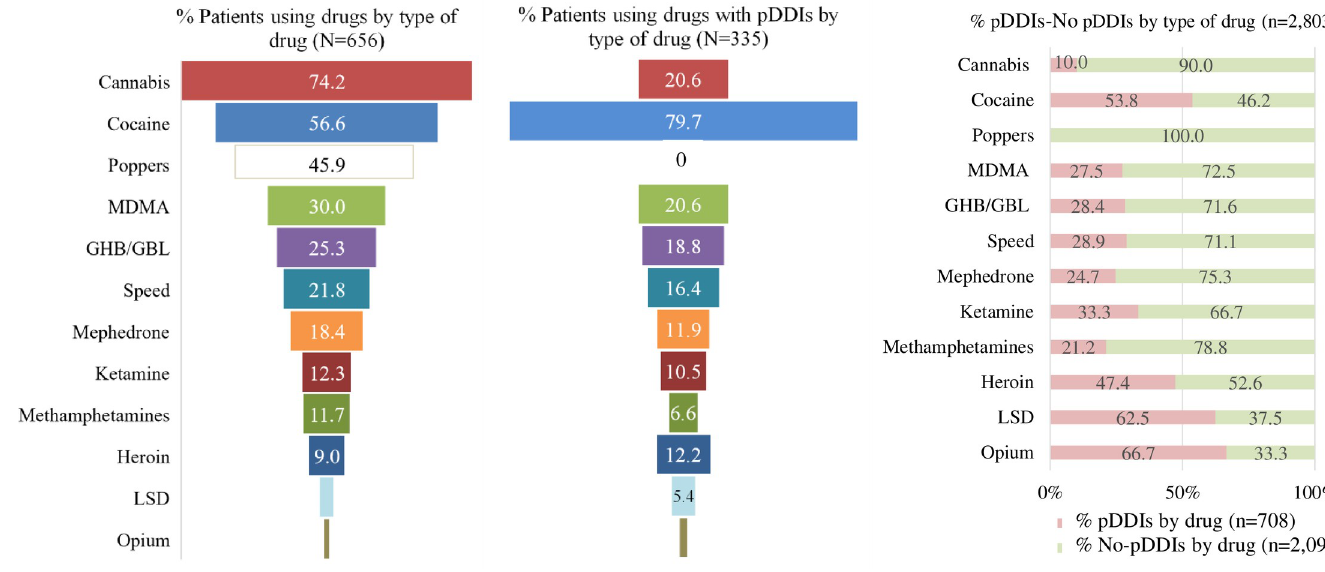
Fig 2. Prevalence of participants using drugs, with potential interactions and distribution per type of drug. MDMA: 3,4-Methylenedioxymethamfetamine; GHB/ GBL: gamma-hydroxybutyrate/gamma-butyrolactone; LSD: Lysergic acid diethylamide; pDDIs: Potential drug-drug interactions; No-pDDIs: No potential drug-drug interactions; N: patients; n: number of